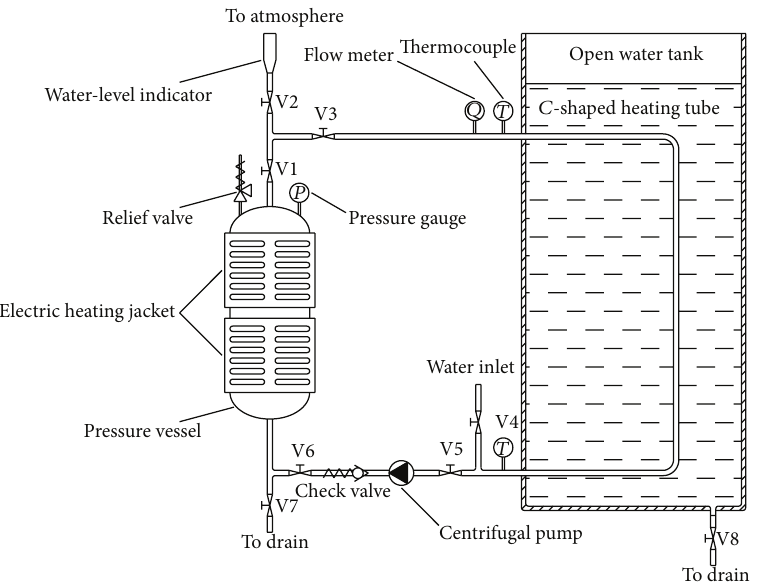
Figure 1: Schematic diagram of experimental system.